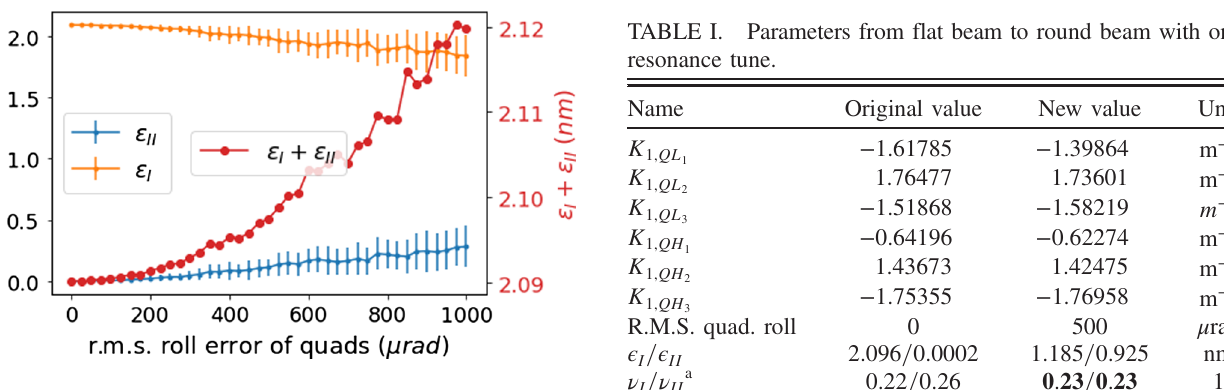
FIG. 6. Emittance variation with quadrupole roll errors when the machine ’ s tune ( 0 . 22 = 0 . 26 ) is off a difference resonance.